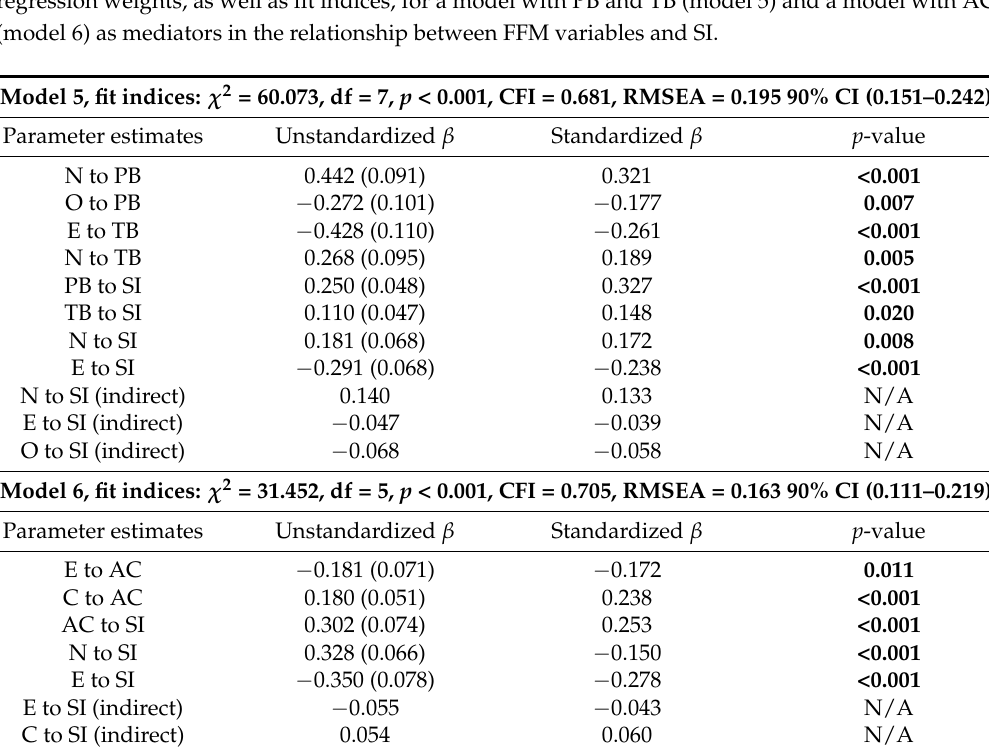
Table 4. Estimated unstandardized (with standard errors) and standardized parameters for the regression weights, as well as fit indices, for a model with PB and TB (model 5) and a model with AC (model 6) as mediators in the relationship between FFM variables and